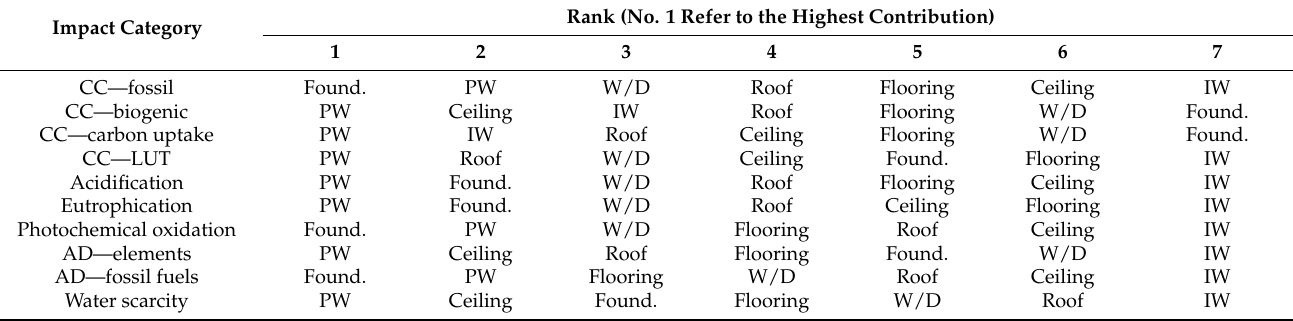
Table 3. Ranking of construction components according to their embodied impact within the impact categories. Rank (No. 1 Refer to the Highest Contribution) Impact Category